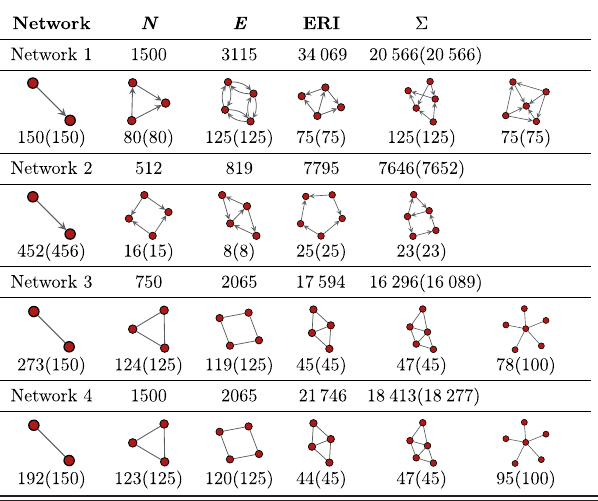
TABLE VII. The motifs obtained for networks corresponding to realizations of uniform subgraph covers. The quantities corresponding to the ensembles used to generate the networks are given in